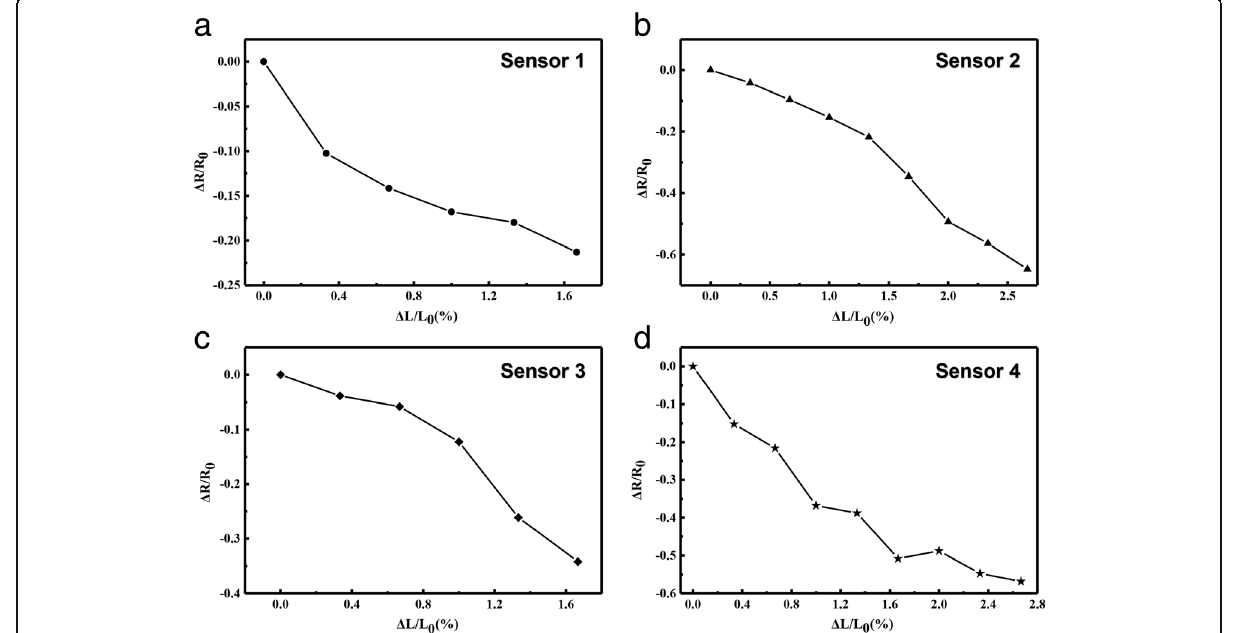
Fig. 6 The relative resistance changes of the sensors based on AgNWs & MNs in mass ratio of a 1:0, b 5:1, c 2:1, and d 1:1 with